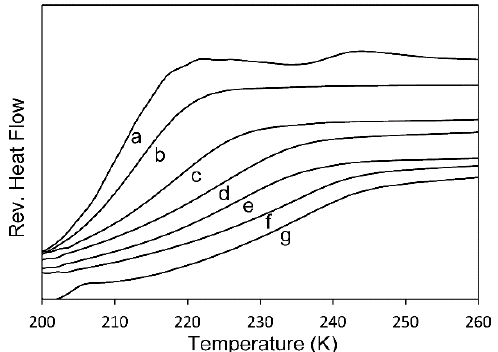
Figure 8. Thermograms obtained by modulated DSC of ( a ) POEGMA; ( b – f ) P(OEGMA- co -DEGMA): ( b ) 79:21, ( c ) 50:50, ( d ) 31:69, ( e ) 24:76, ( f ) 14:86 (mole ratio); and ( g ) PDEGMA.